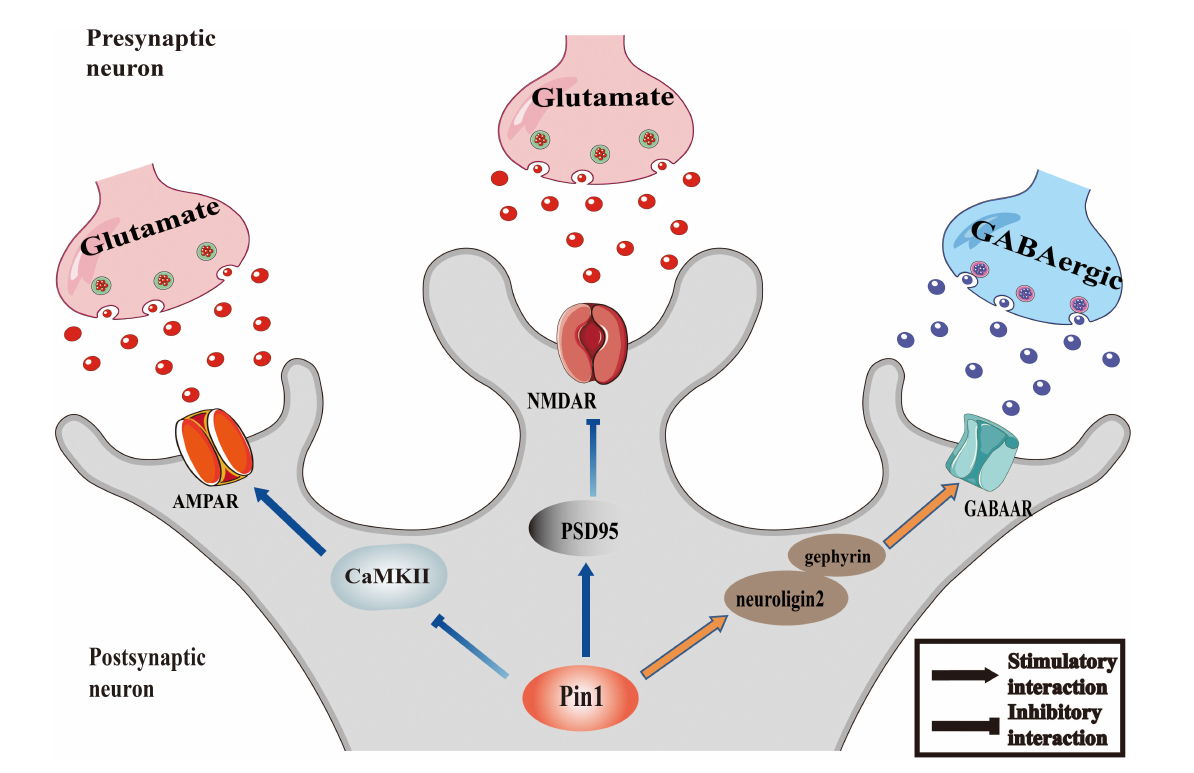
FIGURE1 Pin1 as regulator of synaptic activity. The function of AMPAR could be inhibited by the interaction between Pin1 and CaMKII. Pin1 could down regulate the NMDA-mediated synaptic transmission by binding to PSD95. And the transmission of GABAergic will be modulated by Pin1 interfering the function of neuroligin2-gephyrin